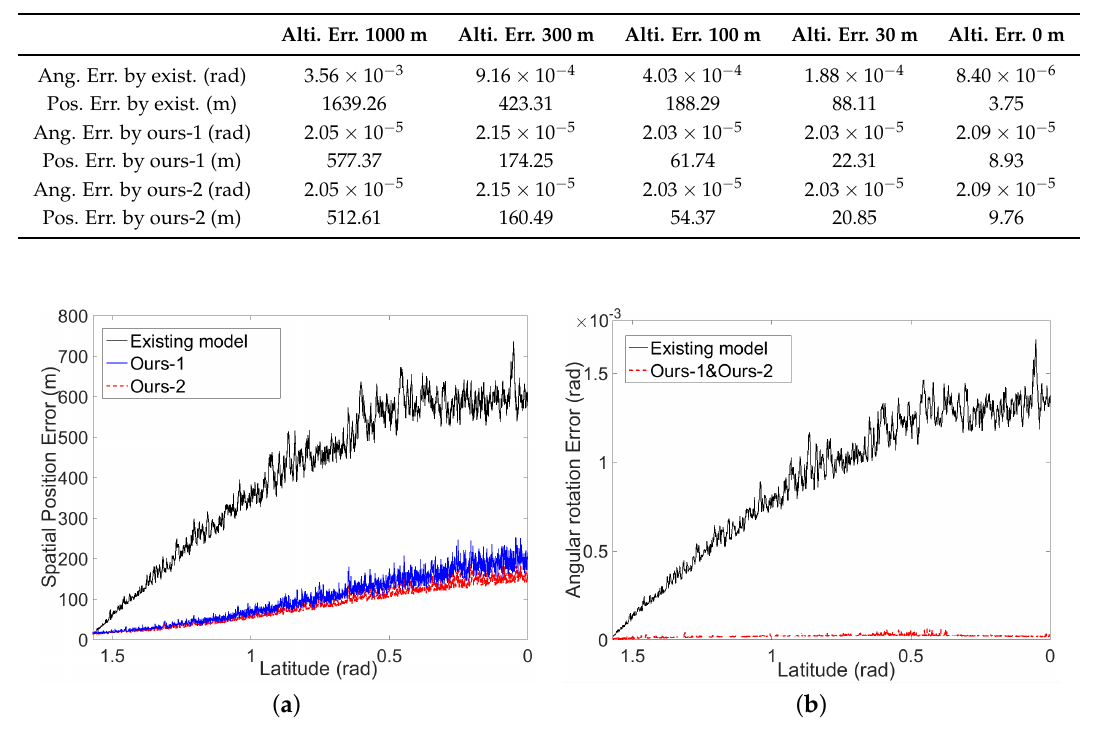
Table 3. Error of estimated EOPs by adding different perturbations to real altitude values at the GCPs. Here “Alti. Err.” indicates the error of altitude values.